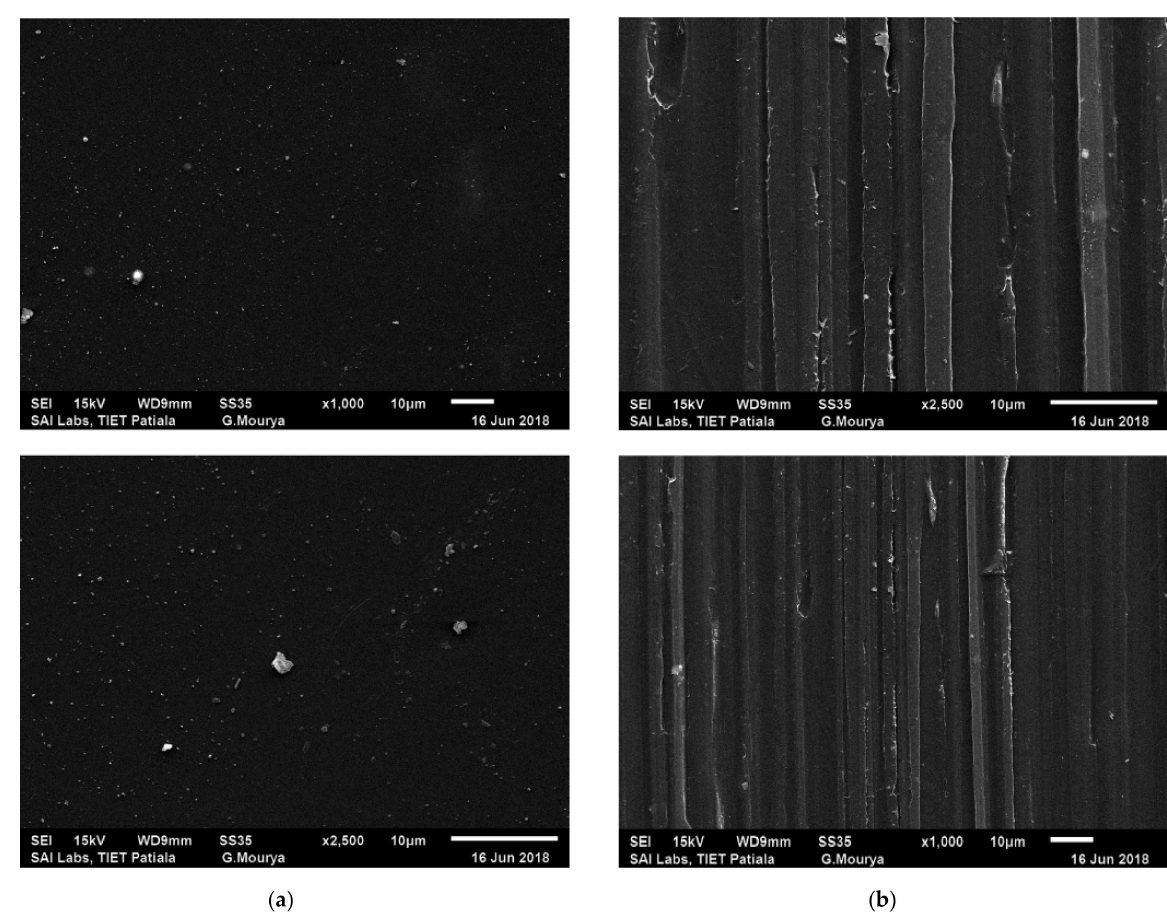
Figure 6. The top and bottom surface SEM images of poly(styrene)-p-xylene coatings are shown in ( a , b ), respectively. The films appear to be symmetrical, thick, and macroscopically non-porous based on these pictures. No macropores were found in the final coating; therefore, this is a strong indicator of a one-phase system with no bulk flows during drying (used with copyright permission) [37]. ( a ) Top surface SEM images of poly(polystyrene)/p-xylene. Coatings had an initial solvent weight fraction = 0.84, initial coating thickness = 487 microns, T 0 = 303 K, and t = 3000 s. ( b ) SEM images of the substrate side of poly(polystyrene)/p-xylene coatings. Initial solvent weight fraction = 0.84, initial coating thickness = 487 microns, T 0 = 303 K, and t = 3000